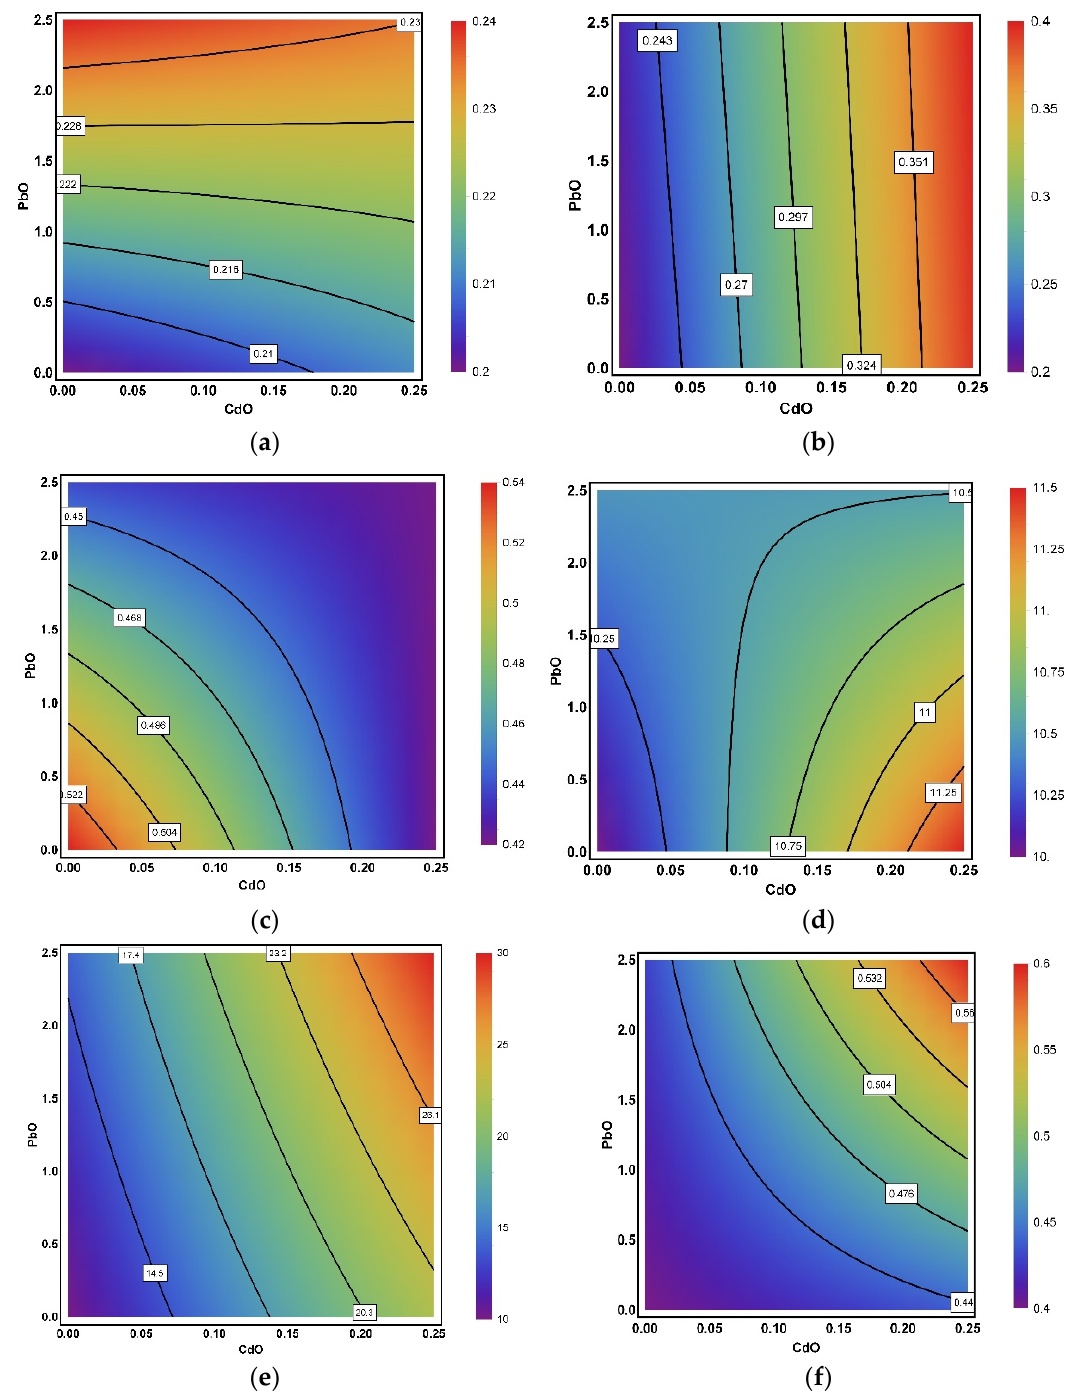
Figure 1. Examples of isobolograms illustrating variations in the type of combined action produced by CdO–NP and PbO–NP on the indices: ( a ) thrombocrit (prevailing single-factor action of PbO–NP, changing to additivity at low doses and to opposite action at high doses), ( b ) eosinophil count (prevailing single-factor action of CdO–NP), ( c ) SH–groups (additivity, changing to subadditivity at high NP doses), ( d ) liver mass (additivity at low NP doses, changing to antagonism at high NP doses), ( e ) acaryotic hepatocytes (additivity), ( f ) coefficient of genomic DNA fragmentation (superadditivity). The axes plot NP doses in mg/kg; numbers on the isoboles show the magnitude of the corresponding effect. The response ranges are distinguished by different colors.